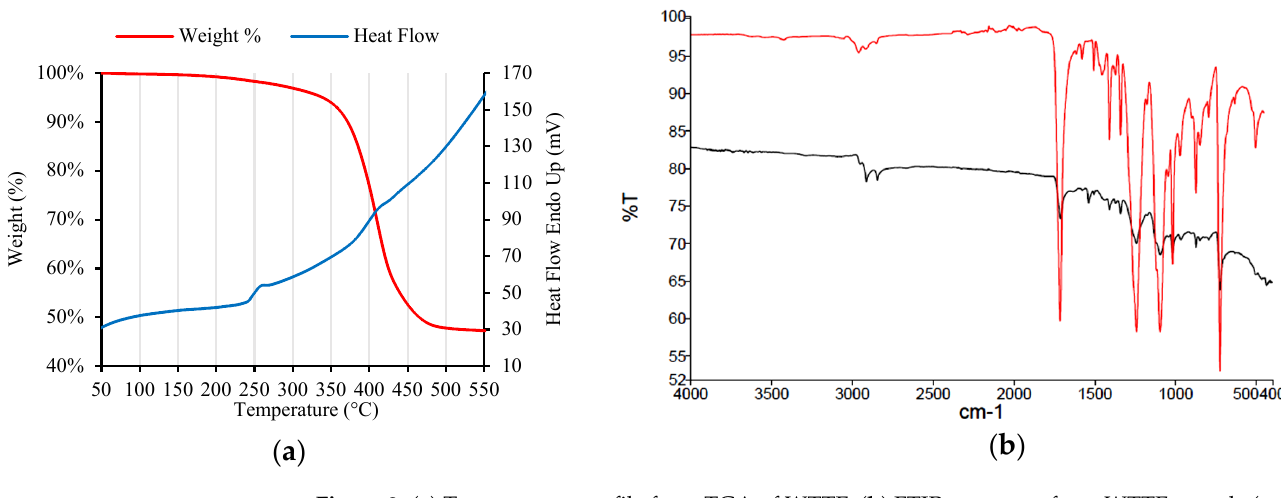
Figure 2. ( a ) Temperature profile from TGA of WTTF; ( b ) FTIR spectrum from WTTF sample (red) and a polyester standard (black).